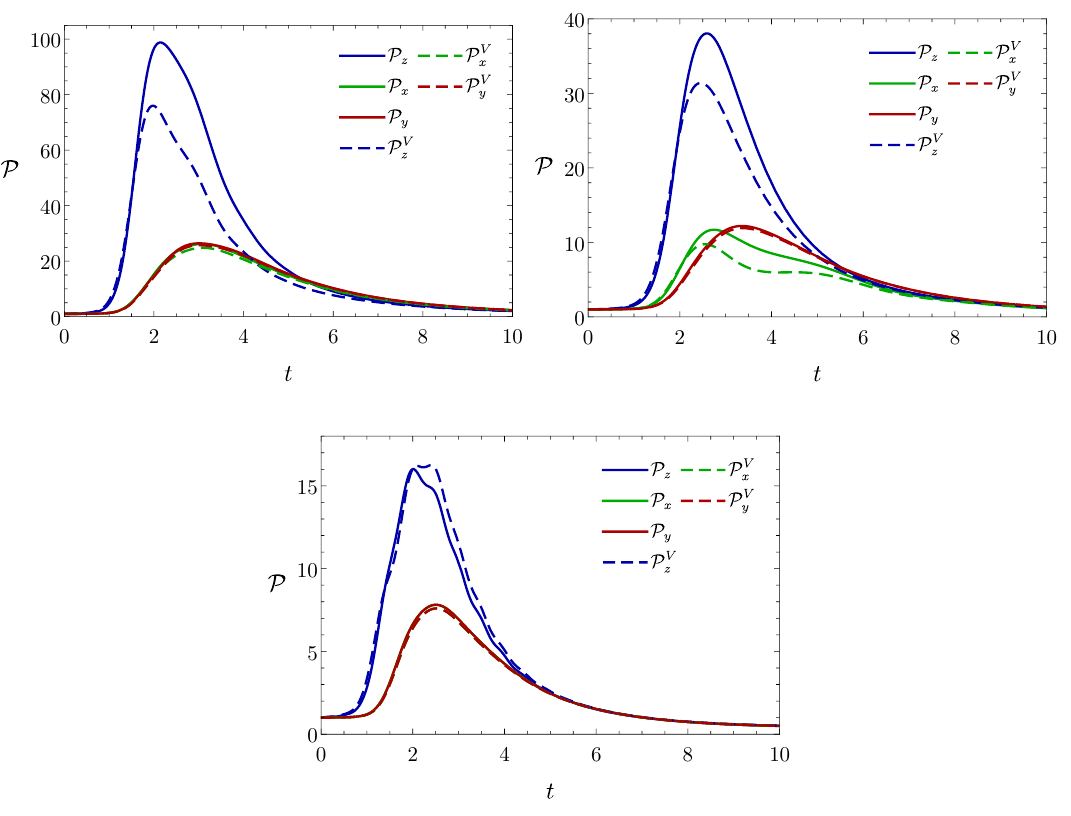
Figure 6 . Pressures along the three active directions as a function of time at the spatial origin. The solid lines represent the full pressures ( P ), while the dashed lines show by the first order i hydrodynamic pressures ( P V ). Top: Charged oblate blob collision with impact parameter δx = (2 , 8) i for the right and left panels respectively. Bottom: Unequal blob